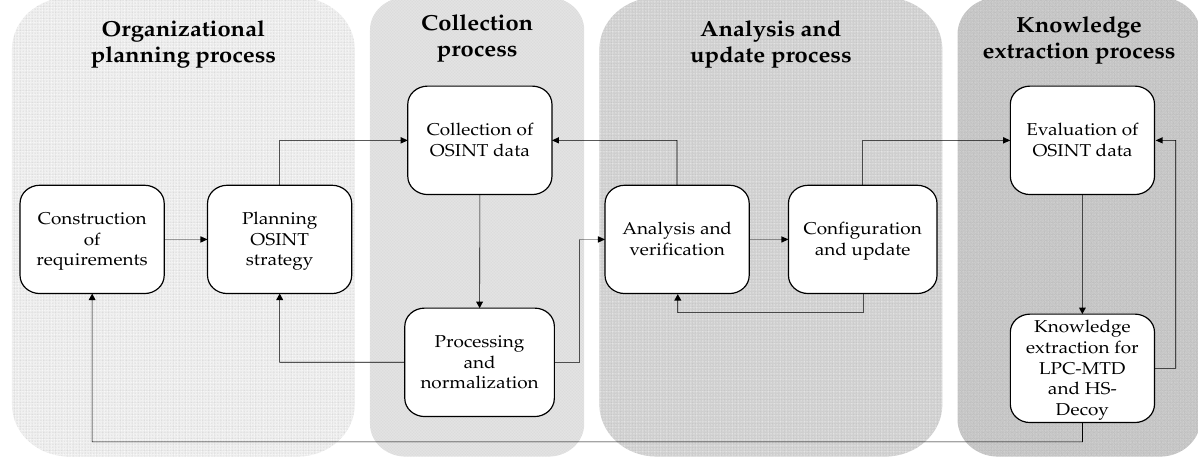
Figure 2. Lower-level overview of the asynchronous parallel chain-based organizational OSINT process.